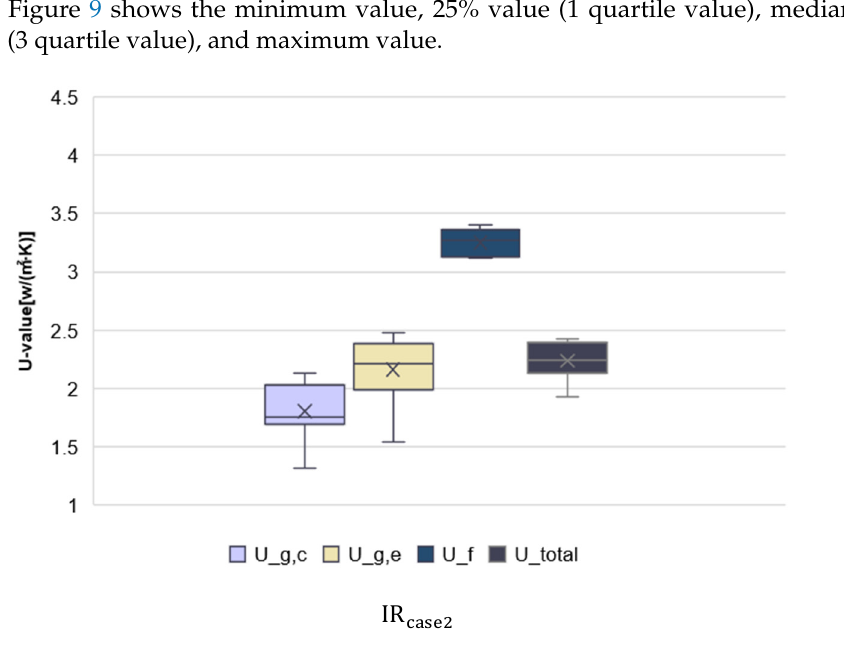
Figure 9. Boxplot of the IR case2 U-value results using the ISO 6946 standard.